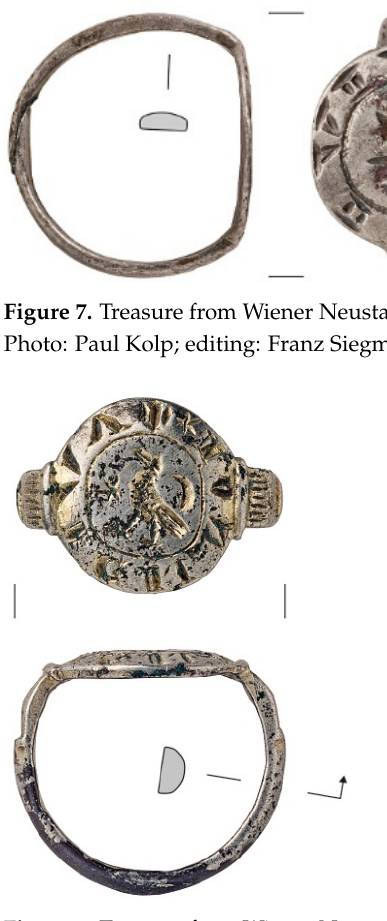
Figure 8. Treasure from Wiener Neustadt. Finger ring with “striding bird” motif, 13th/14th century. Photo: Paul Kolp; editing: Franz Siegmeth.